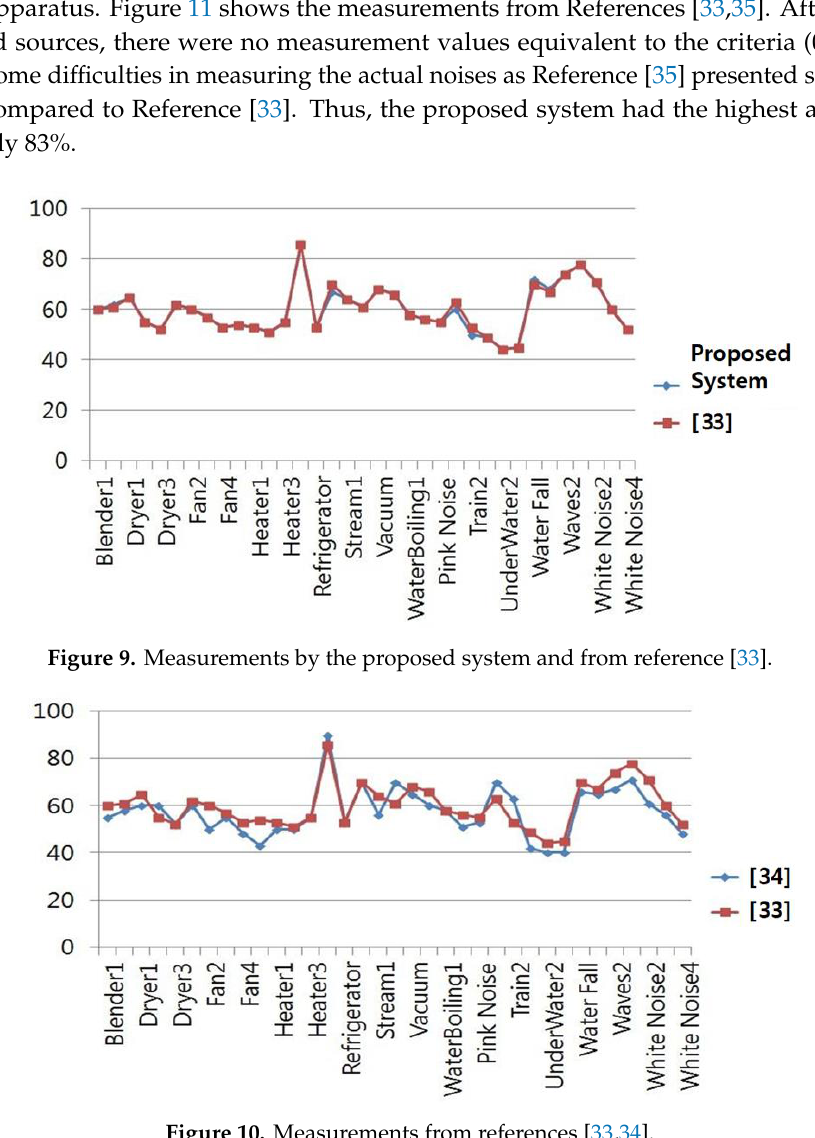
Figure 10. Measurements from references [33,34].